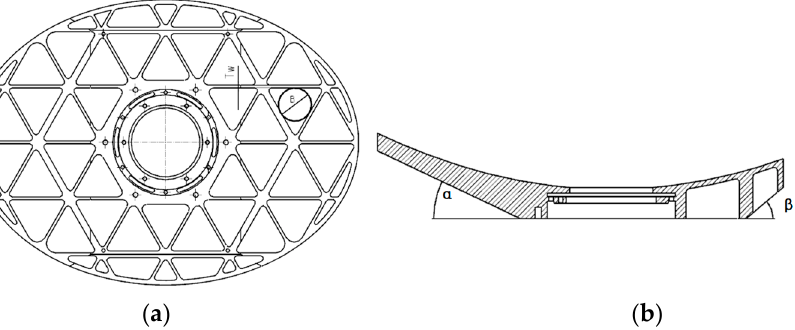
Figure 9. Final design structure of mirror: ( a ) lightweight schematic of mirror back; ( b ) schematic diagram of mirror back trimming.